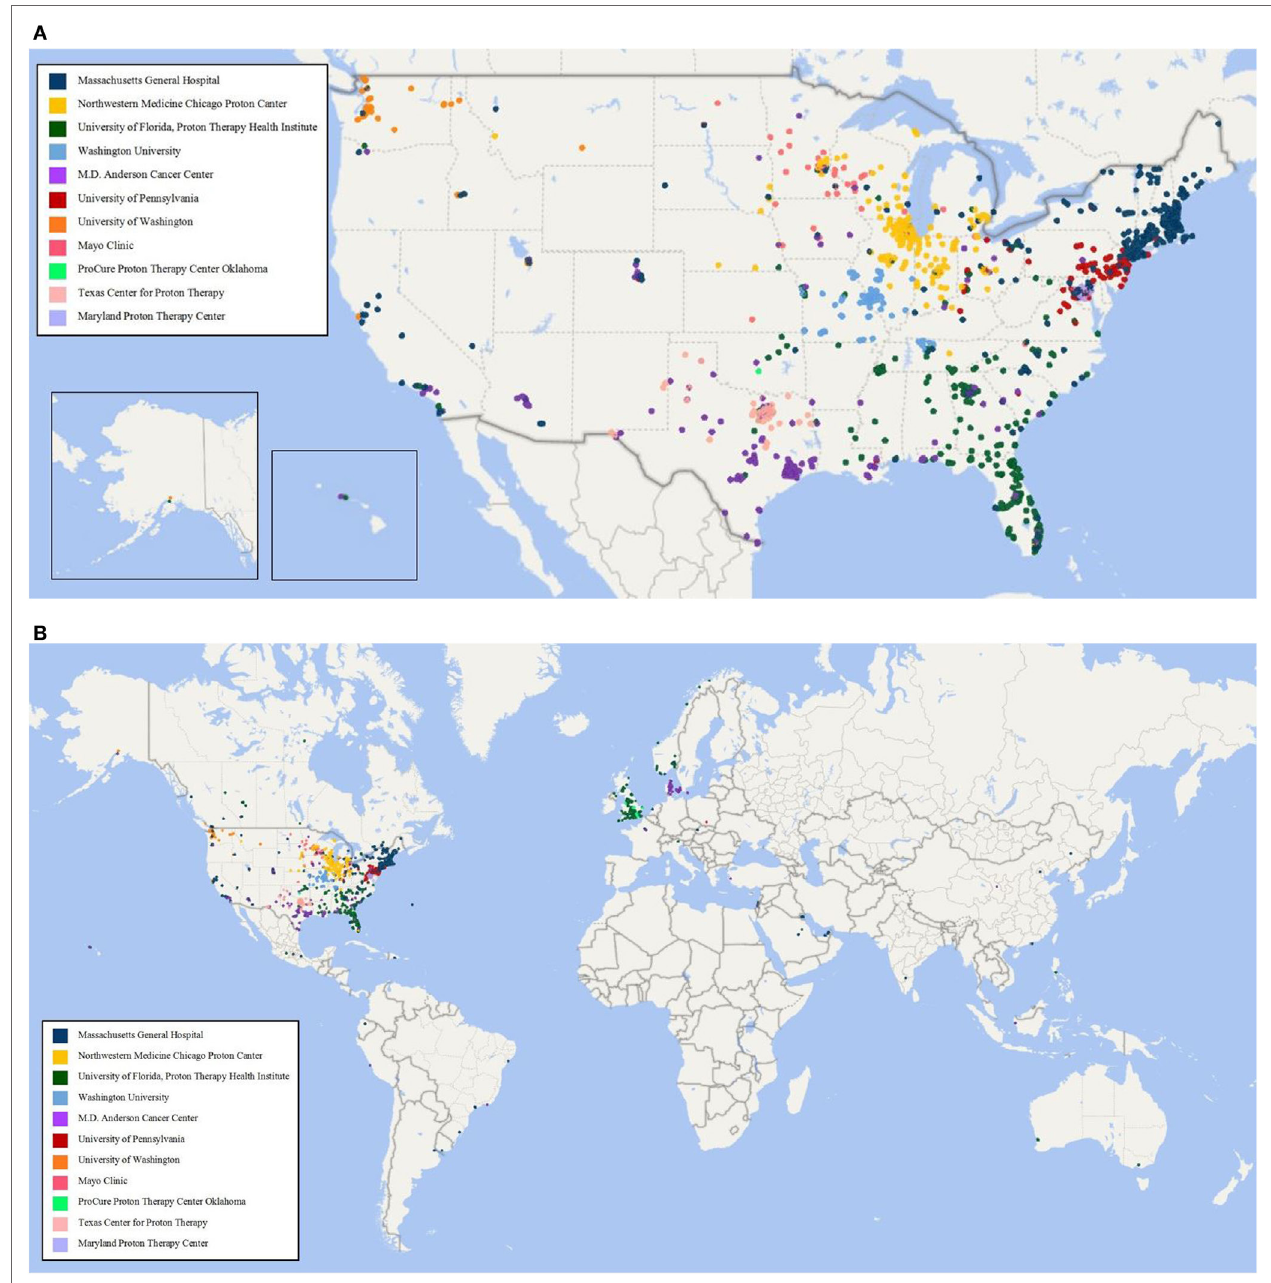
FigUre 3 | (a) Home zip code of children enrolled in the Pediatric Proton Consortium Registry (PPCR) from the United States by treating institution. (B) Global map of children enrolled in the PPCR by treating institution.